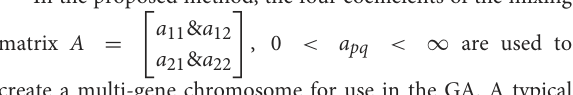
and | f | are column matrix representations of the target image and watermark image zero-padded to be of equal length. F α is the α th order fractional Fourier transform as discussed in section Fractional Fourier